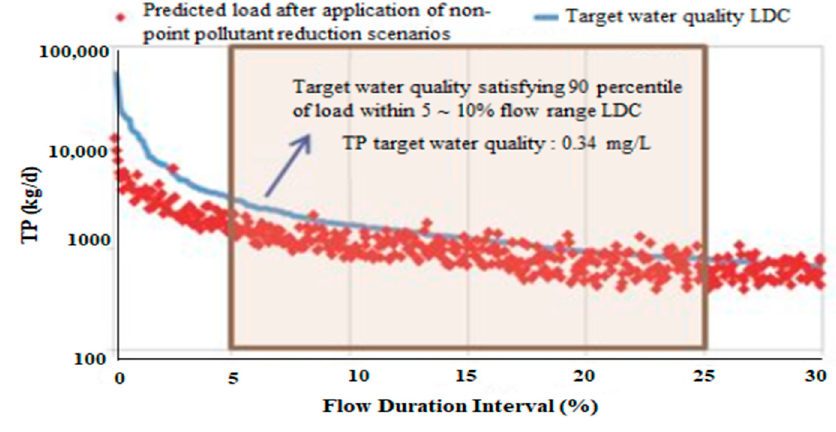
Figure 11. Example of setting water quality target using